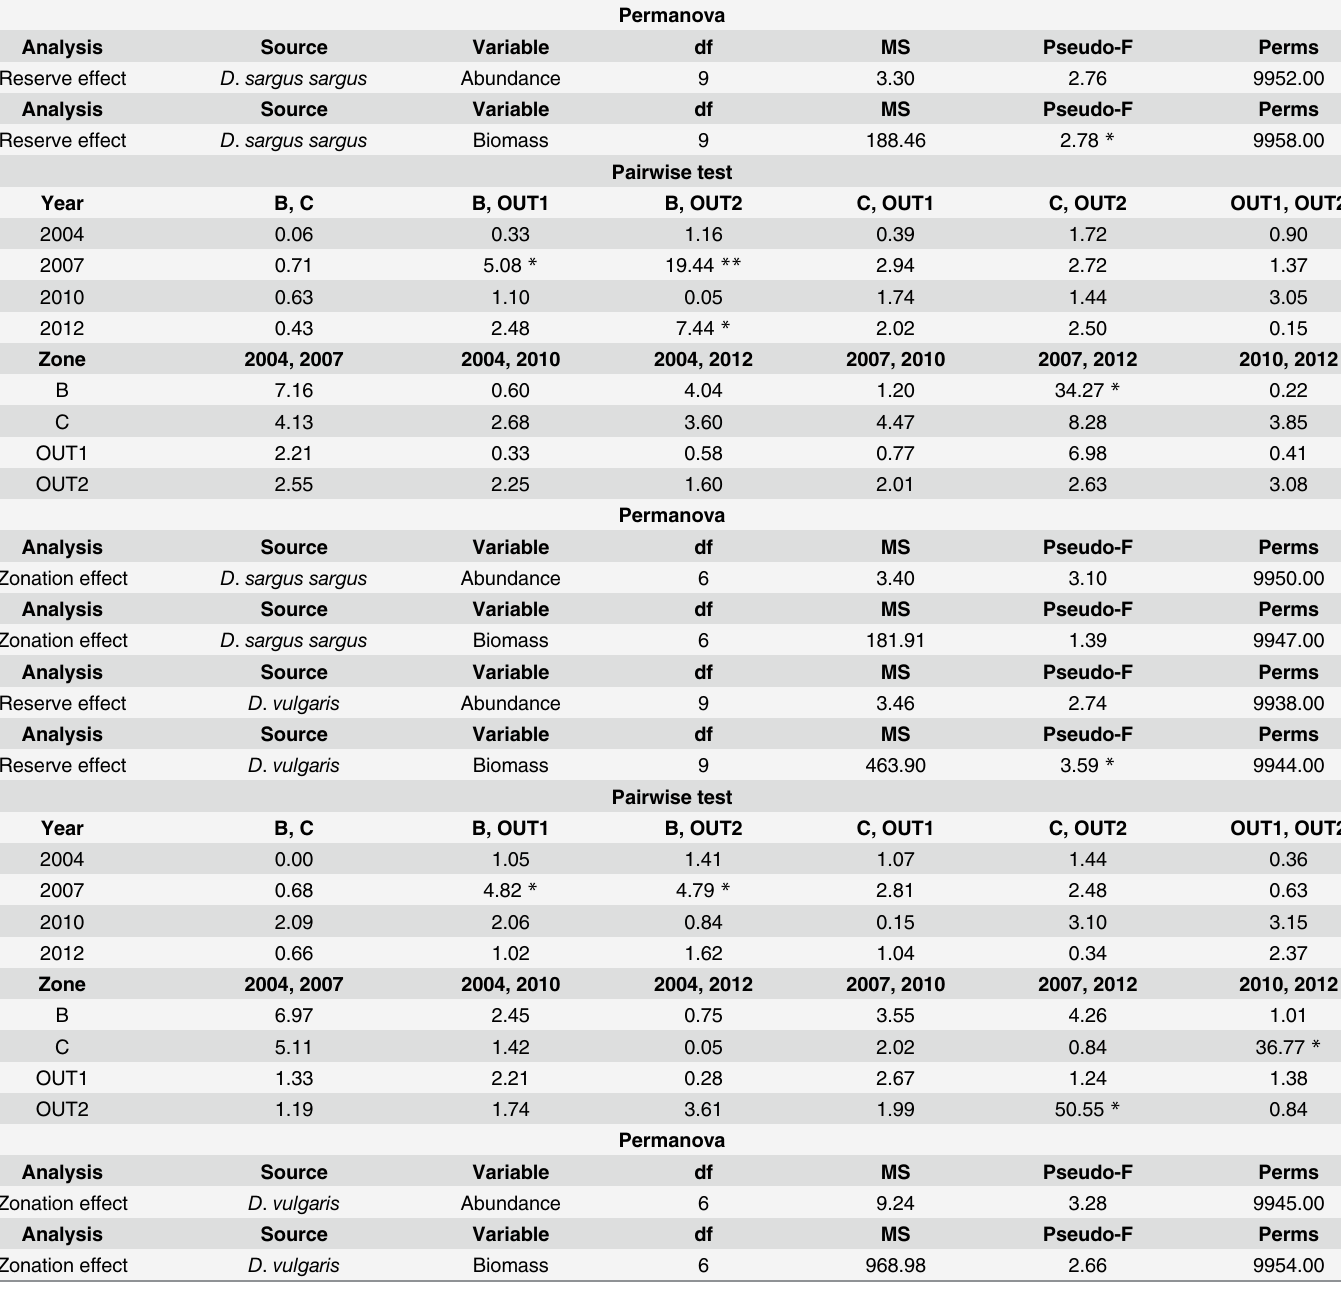
Table 6. Results of univariate Permanova analyses on square root transformed data for “ Year x Protection ” factor for Diplodus species. Pairwise tests are reported in the event of statistical